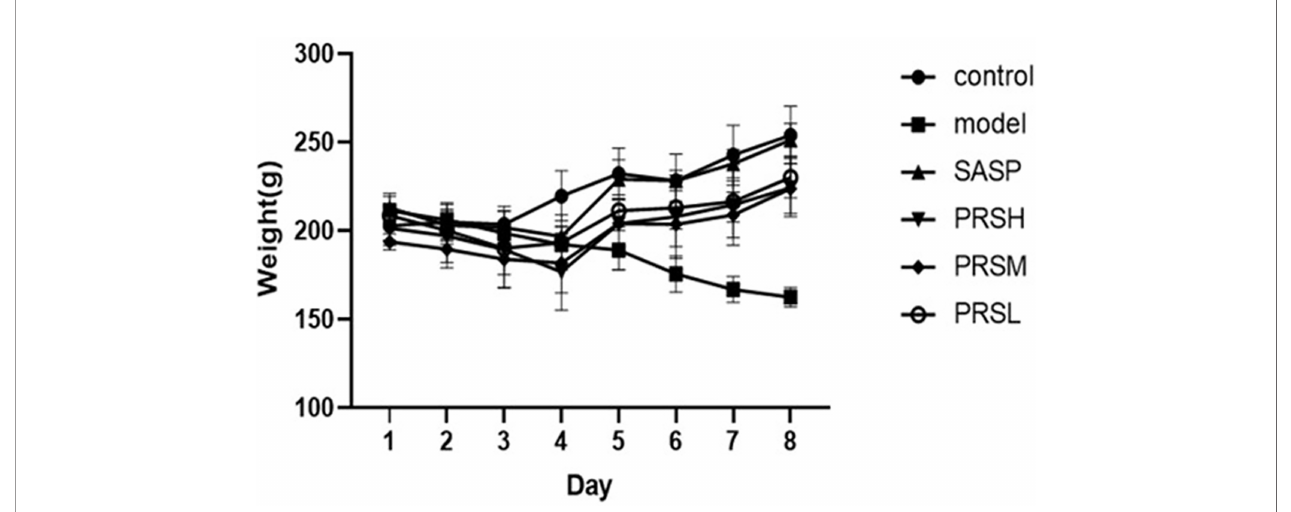
FIGURE 1 | Change of body weight of mice from different groups during modeling